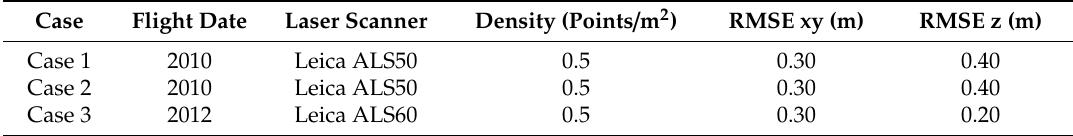
Table 4. Main features of the first coverage LiDAR data.